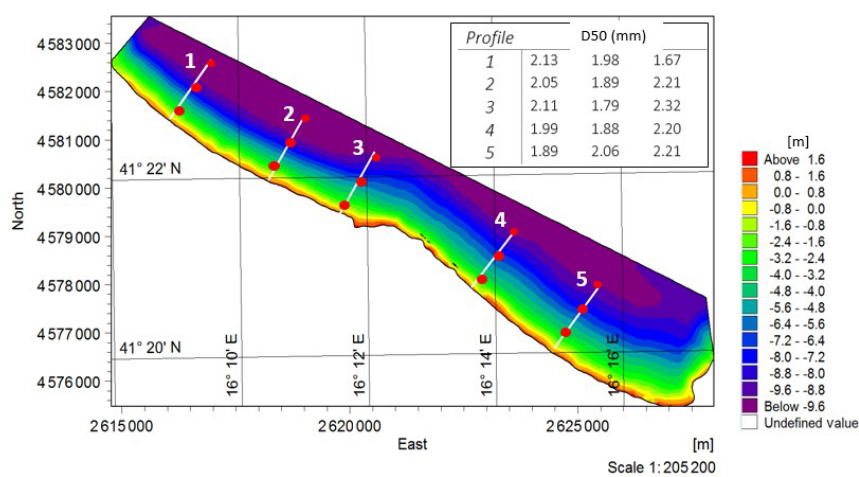
Figure 3. Bathymetry of the study area (Gauss–Boaga coordinates) and cross-shore model profiles. Mean diameters ( D 50 ) measured in three locations along each profile are reported (from the coast to open sea).